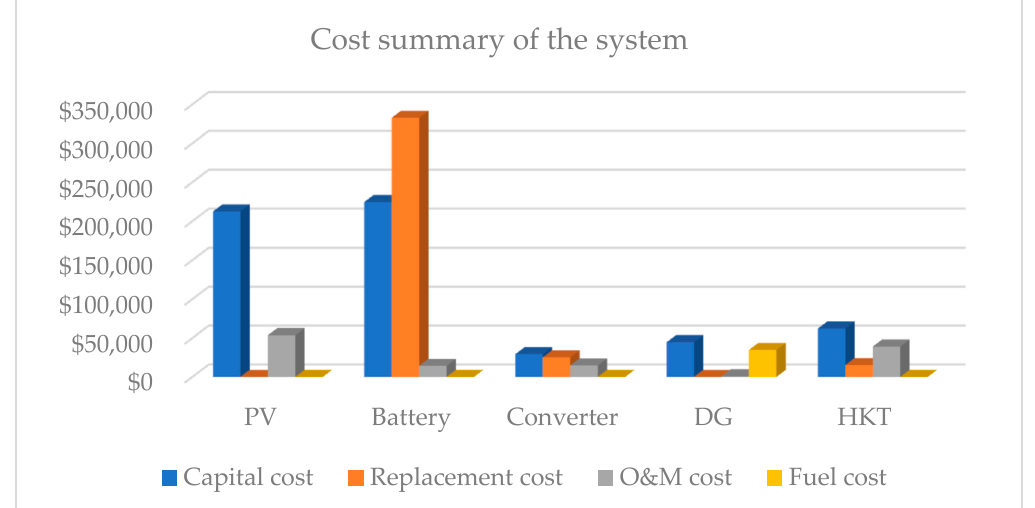
Figure 9. Overall cost summary of the o ff -grid HRES.